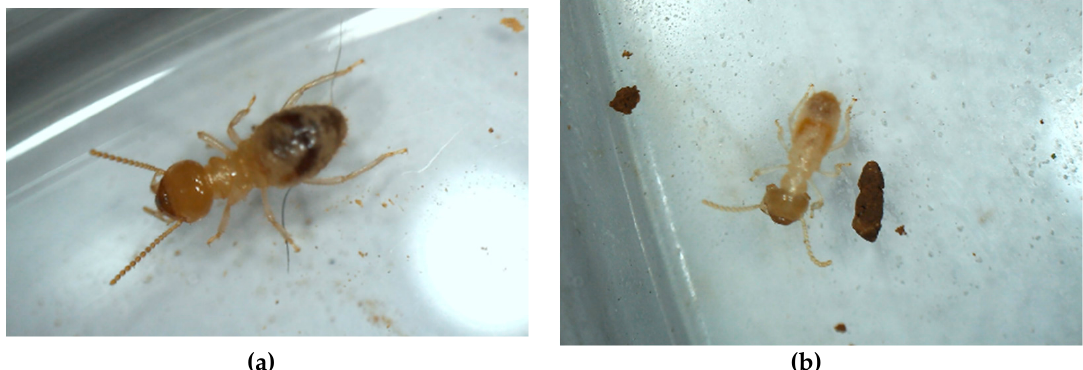
Figure 7. Subterranean termites found during the field test: Microtermes inspiratus Kemner (a) and Coptotermes curvignathus Holmgren (b).